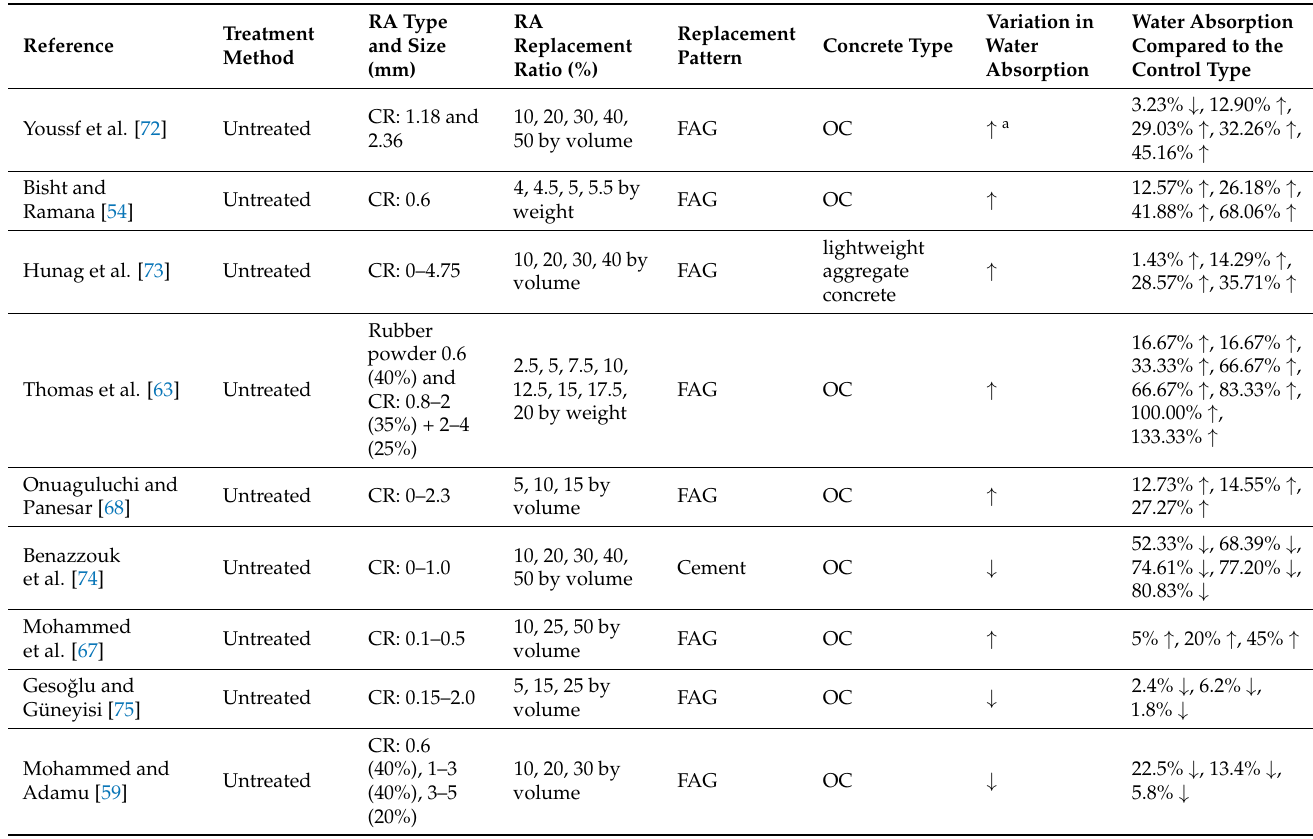
Table 6. Influence of rubber on the concrete water